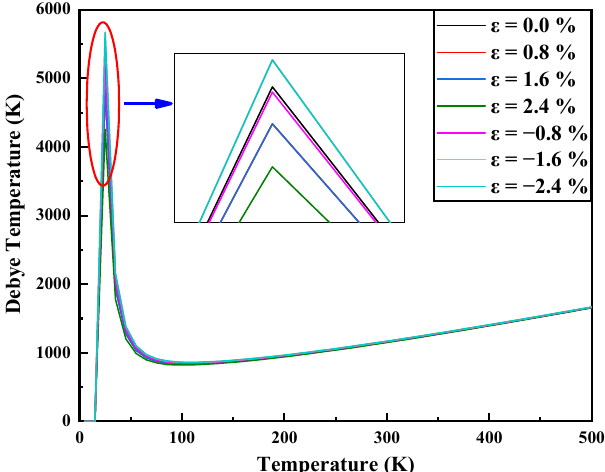
Figure 6. Debye temperature of a single layer of MoS 2 under different strains.